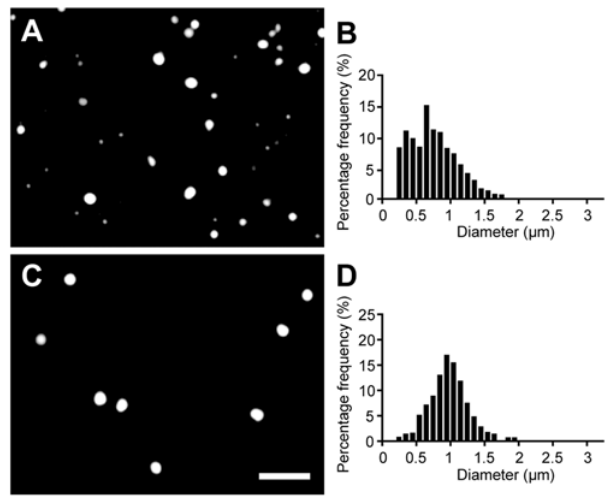
Figure 3. Preparation of monodisperse POPC vesicles. (A) POPC vesicles (containing 2 mM HPTS, in 0.2 M Na-bicine, pH 8.5) after being extruded through 1- m m-diameter pores, and (B) the corresponding size distribution, shown as percent per 0.1 m m bin. (C) After 12 rounds of dialysis using membranes with 0.8- m m-diameter pores, and (D) the corresponding size distribution. Scale bar, 5 m m.